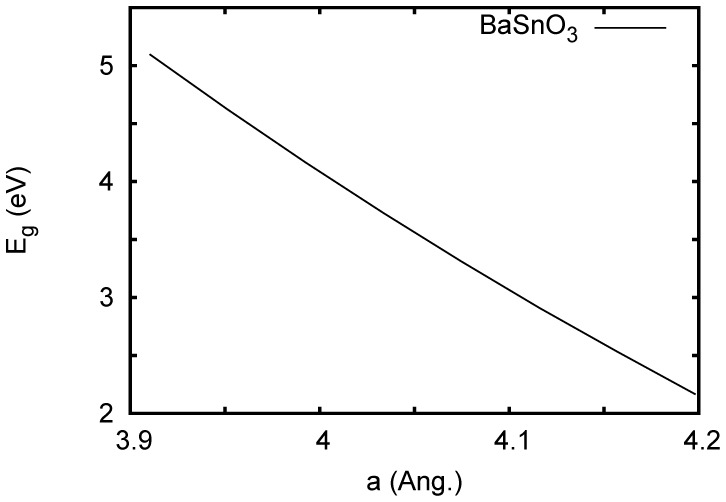
Calculated band gap of BaSnO3 as a function of lattice parameter with the TB-mBJ potential.